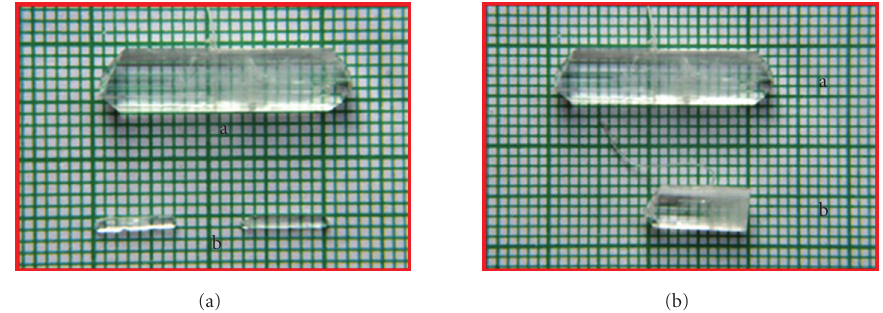
Figure 10: Photograph of L-threonine crystal grown from aqueous solution by slow cooling